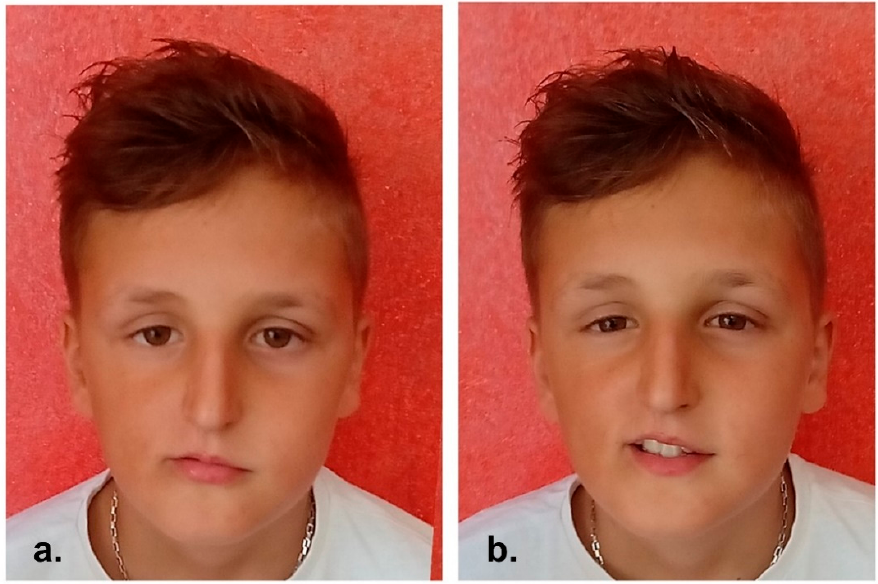
Figure 3. ( a , b ) 4-year post-operative clinical pictures.